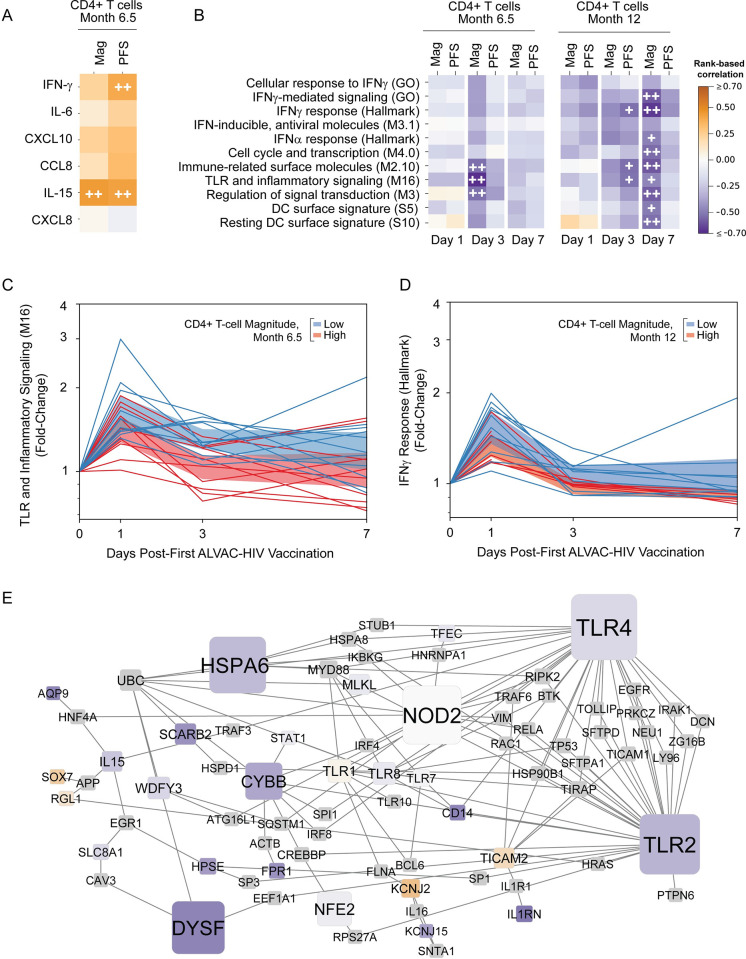
Rapid resolution of the early innate response is associated with higher CD4+ T-cell responses to HIV-1 Env at Months 6.5 and 12.A) Heatmaps representing correlations between Month 6.5 Env-specific CD4+ T-cell magnitude (“Mag”) or polyfunctionality score (“PFS”) and Day 1 cytokine fold-change compared to baseline. FDR-q< 0.2 (+) or < 0.1 (++). B) Heatmaps representing correlations between average module scores and Month 12 Env-specific CD4+ T-cell Mag and PBS. FDR-q< 0.2 (+) or < 0.1 (++). C, D) “TLR and inflammatory signaling (M16)” (C) and “IFNγ response (Hallmark)” (D) module scores at Days 1, 3, and 7. Each line represents the module score for 1 participant. Individual trajectories colored by Month 6.5 median-split Env-specific CD4+ T-cell response magnitude (blue = low and red = high CD4+ T-cell response); shaded region shows 95% CI of mean. E) Protein-protein interaction subnetwork generated from DEGs present in the “Immune-related surface molecules (M2.10)”, “TLR and inflammatory signaling (M16)”, and “Regulation of signal transduction (M3)” modules. Edges represent protein-protein interactions. Nodes are sized according to degree; only nodes that had degree ≥2 in the original network generated from all the genes from the above modules are shown. Nodes are colored according to correlation of Day 3 log fold-change with CD4+ T-cell response magnitude at Month 6.5 (same key as in A). Non-DEGs are shown in gray.